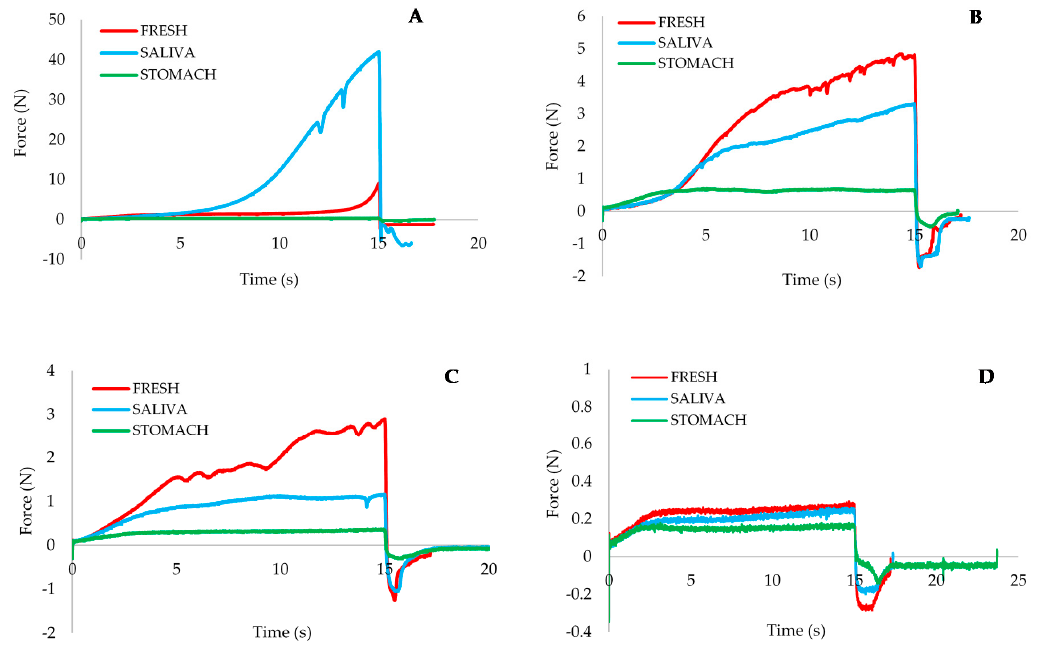
Figure 3. Extrusion profiles of the studied spread and after oral and gastric in vitro digestion. ( A